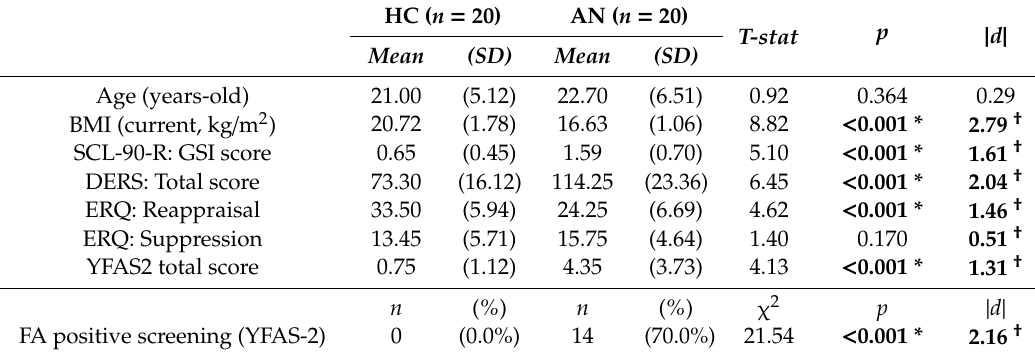
Table 1. Comparison of the clinical profile between groups.